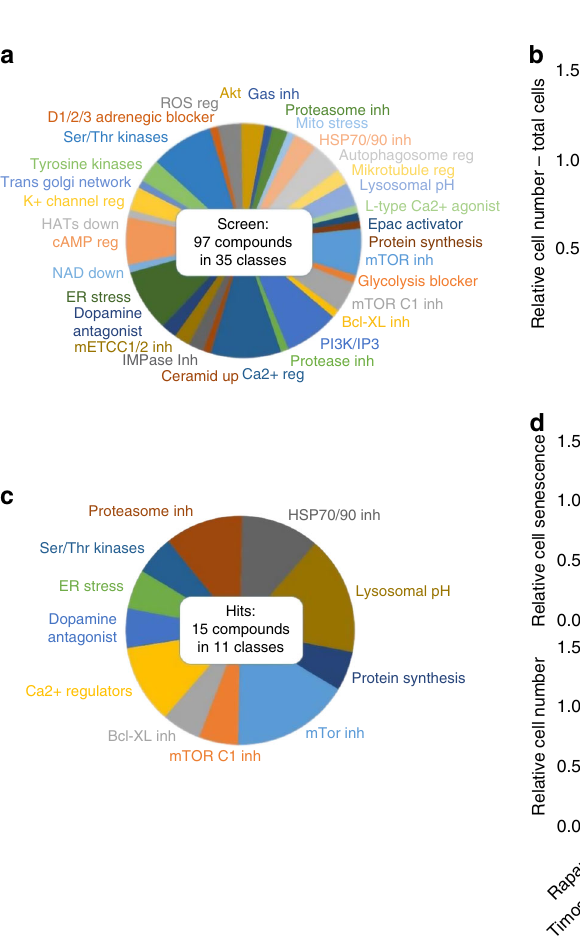
Fig. 4 Screening of a library of autophagy regulators yields senolytics. a Pie chart indicating the different functional groups of drugs in the autophagy library used in the screen. b The primary screen of all 97 autophagy regulators at 1 mM concentration. Plotted on the x -axis is the number of senescent cells in the drug-treated cultures relative to cells treated with vehicle only. On the y -axis is the fraction of total cells remaining after drug treatment relative to vehicle treated controls. Drugs that reduce the number of senescent cells > 50% can be found in the blue shaded area . Drugs that cause no change in cell number (senomorphics) are indicated by blue dots . Drugs that caused a decrease in total cell number to < 75% (potential senolytics) are indicated in red . Grey dots indicate drugs that lead to no signi fi cant change in cell senescence at the concentration used. c Pie chart indicating the functional groups of potential senescence-modulating drugs identi fi ed in the autophagy library. d Independent validation of the primary screen expressed as cell senescence and cell number relative to untreated control cultures (UT) of senescent cells. Known lysosomal inhibitors (lysosomal pH changing compounds, Fig. 4C) were excluded. All drugs were used at 1 μ M, n = 3, graphed + SD. * p < 0.05, two-tailed Student ’ s t